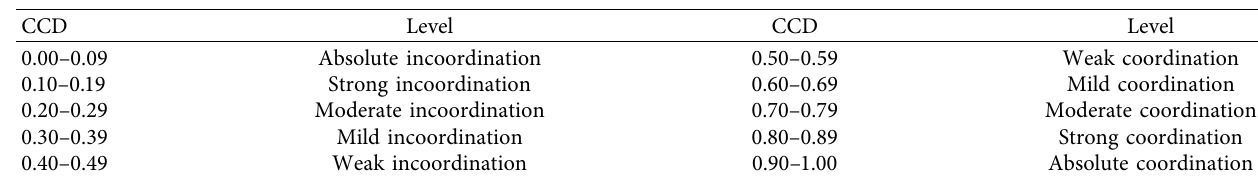
Table 3: CCD levels.